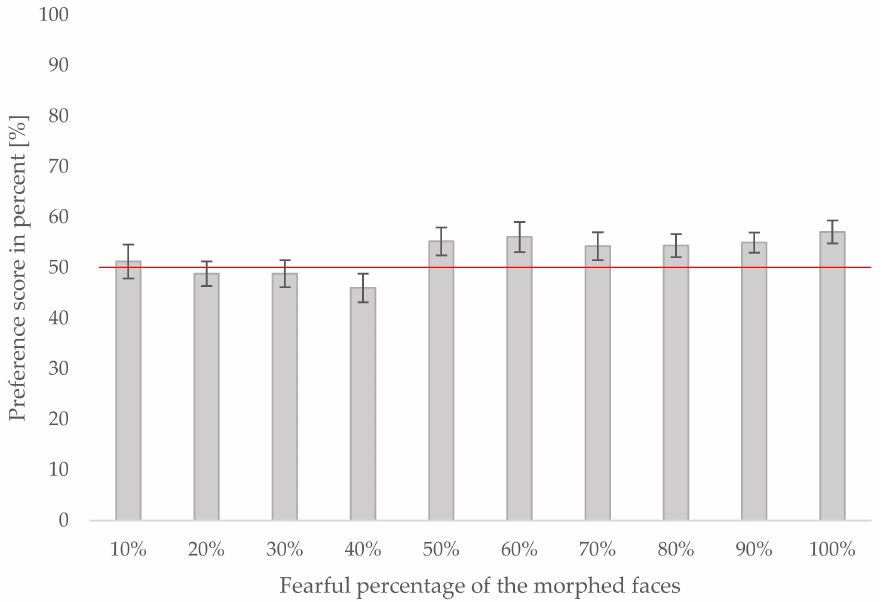
Figure 4. The preference scores at each morph level (10% to 100% of fearful facial expression) in all infants regardless of crawling ability. Error bars indicate the standard error of the